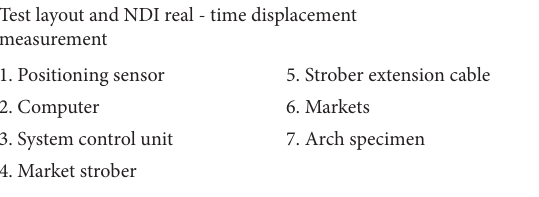
Figure 2: Setup for the lateral-torsional buckling test [37].